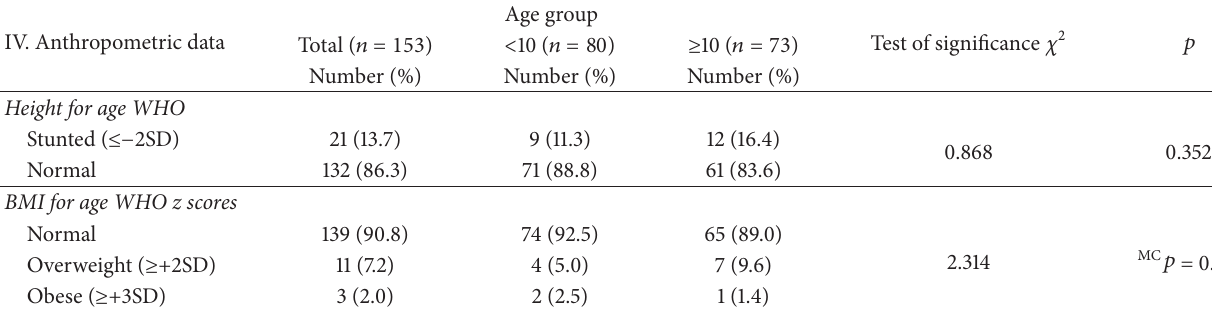
Figure 2: Clinical assessment.